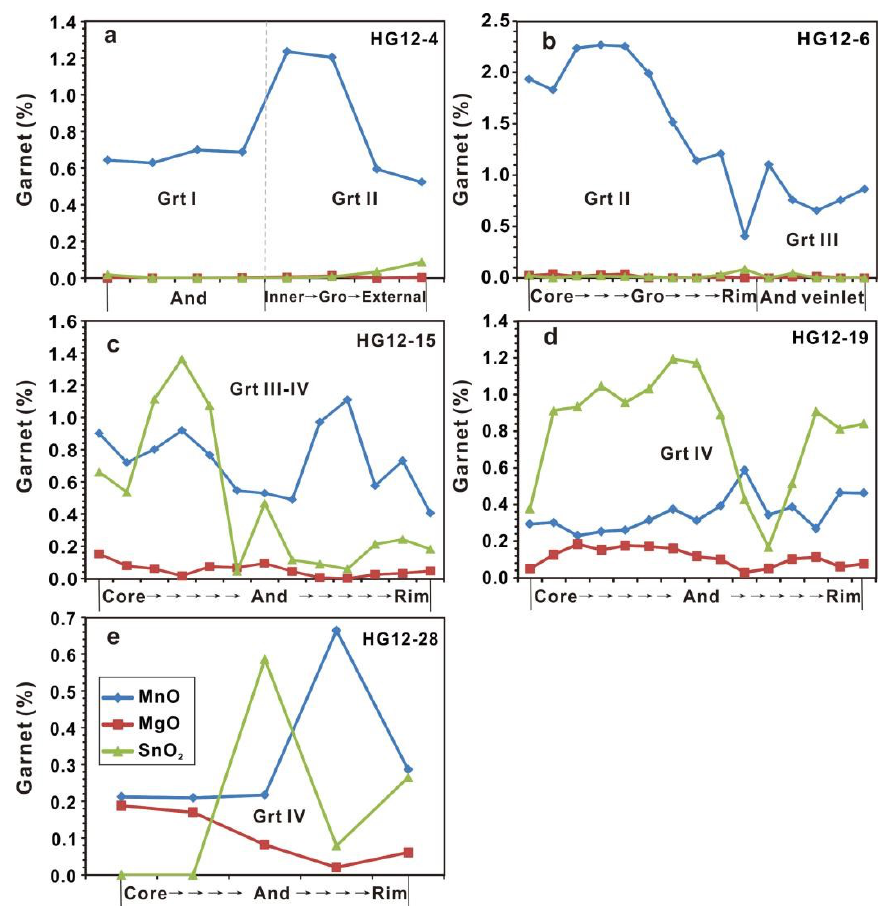
Figure 9. MnO, MgO, and SnO 2 content variations in the garnets of different mineralization stages from the Huanggang deposit.